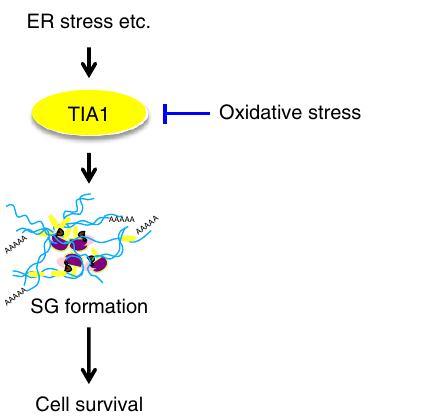
Figure 5 | Oxidative stress suppresses SG assembly. When cells are exposed to ER stress, SGs are assembled mainly through homo- oligomerization of TIA1. SG formation is a major adaptive defence mechanism to protect cells from apoptosis. When cells are simultaneously exposed to ER stress and oxidative stress, TIA1 is oxidized and loses its ability to mediate SG formation, resulting in the promotion of